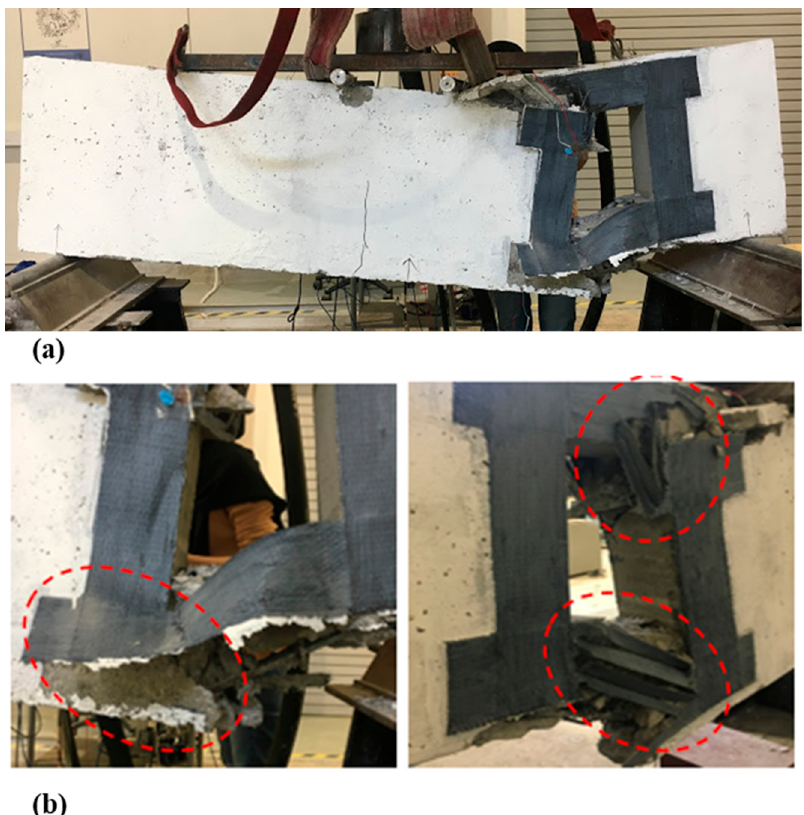
Figure 13. ( a ) Failure mode and cracking pattern of deep beam B3b; and ( b ) CFRP detached from the concrete and tore into two for deep beam B3b.